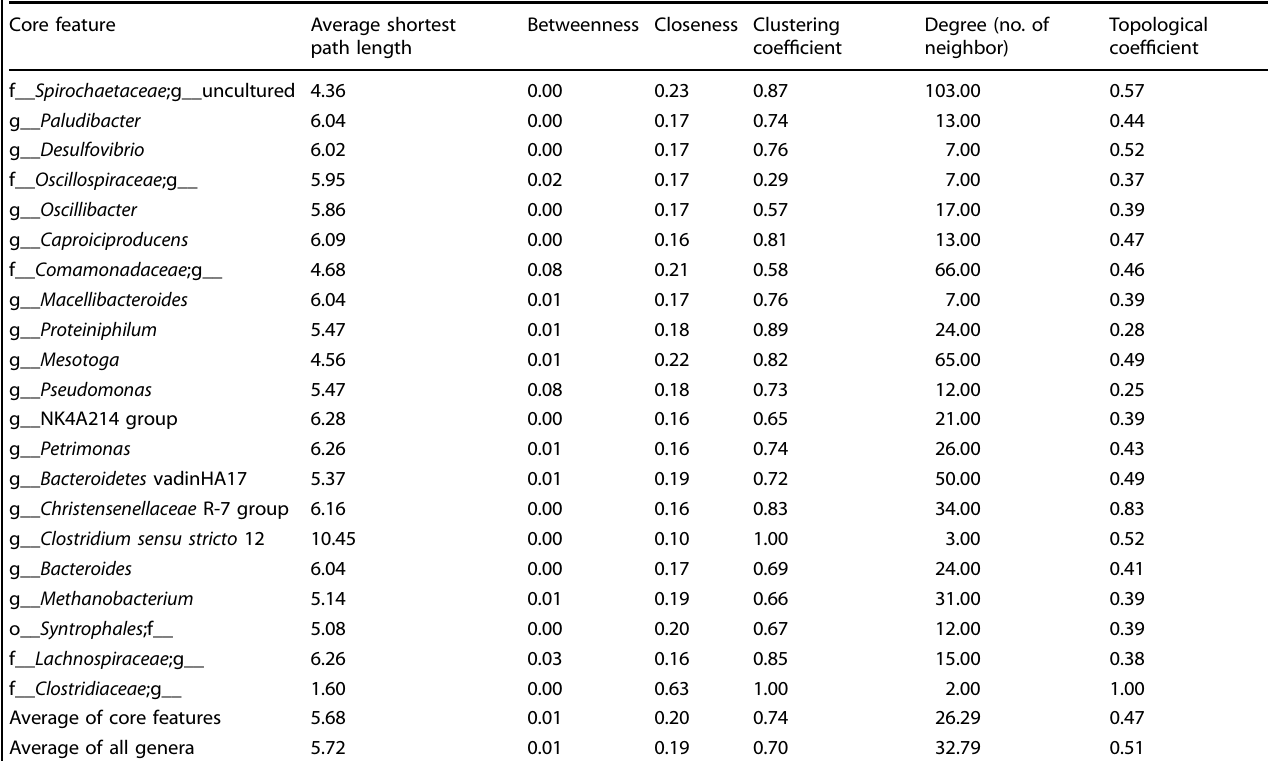
Table 1. Topological properties of core features in the microbial network at the genus level. Core feature Average shortest